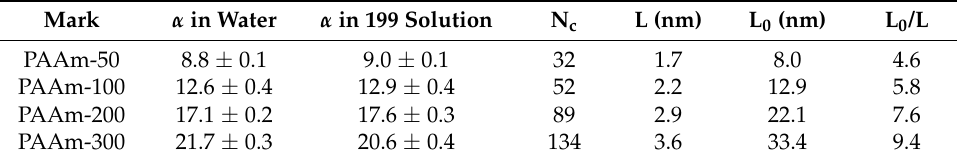
Table 1. Selected parameters of the networking density for PAAm hydrogels: α —swelling degree; N c is the number of monomer units among cross-links; L—the average distance between cross-links; L 0 —the average geometric length of the